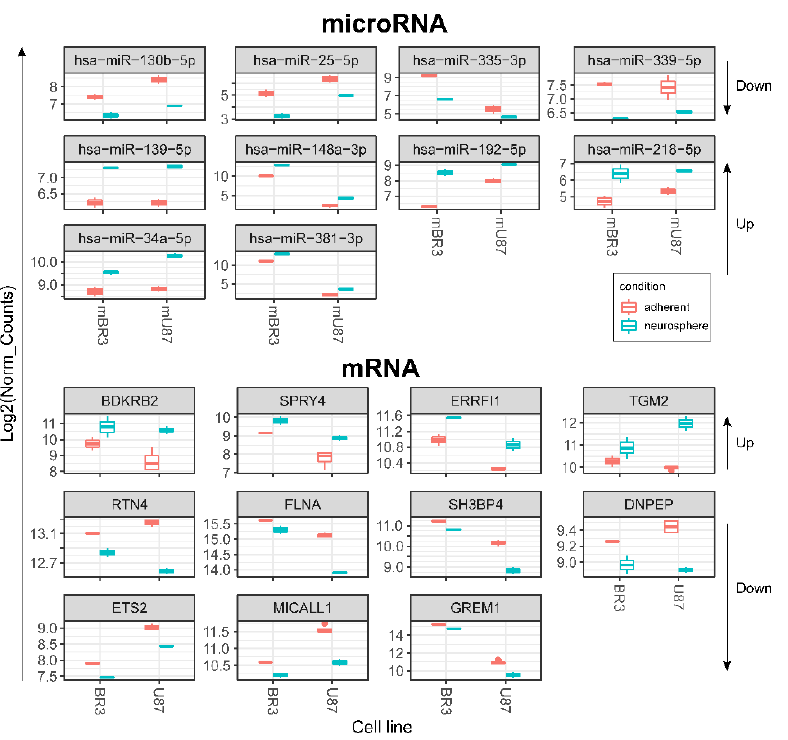
Figure 5. Box plots of DESeq2 normalised expression values of mRNAs and miRNAs grouped by GBM cell cultures and coloured red for monolayer (adherent) cultures and cyan for corresponding NS. Differentially expressed transcripts meet the criteria: DESeq2 pval < 0.05, Log2FoldChange > 0 for upregulated or log2FoldChange < 0 for downregulated (for both BR3 and U87 adherent/neurosphere pairs in one direction—unidirectionally “up” or “down”). Arrows on the right show direction of RNA expression changes in GBM NS for the horizontal block of plots.